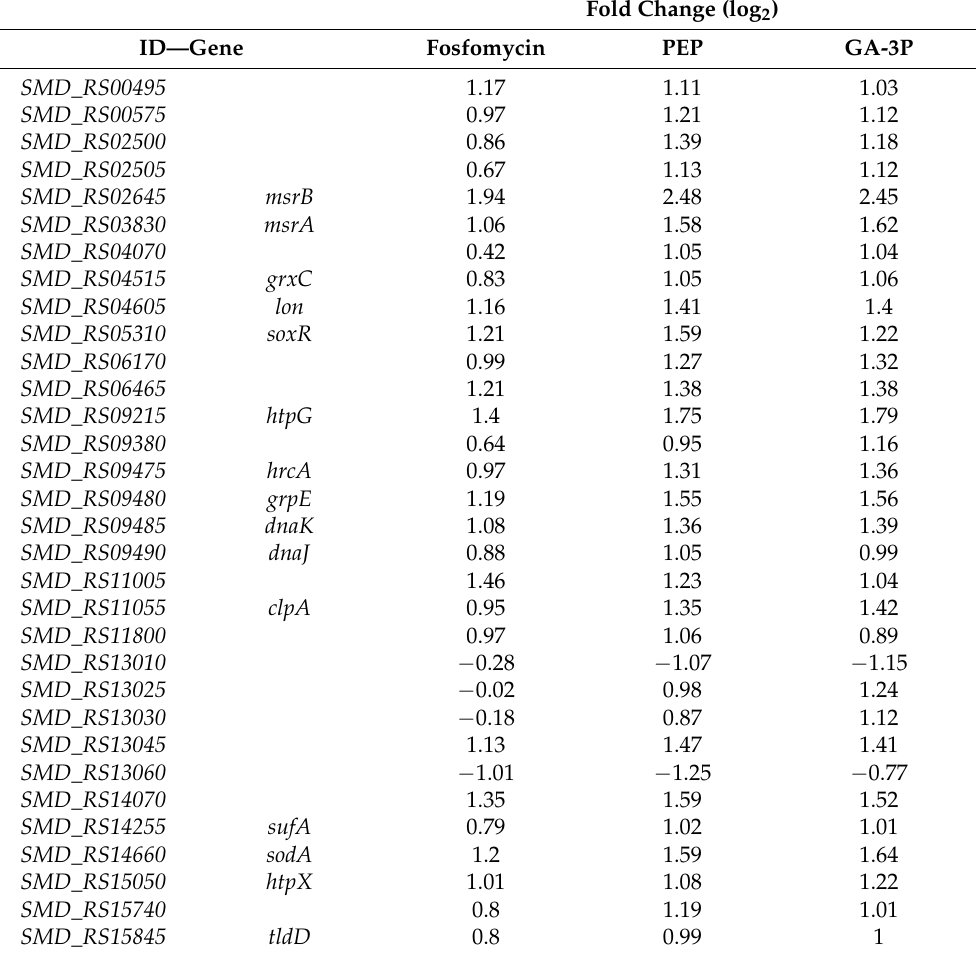
Table 2. Fold change (log 2 ) of genes related to stress response presenting different levels of expression after the treatments, in comparison with the wild-type D457 strain without treatment. Fold Change (log 2